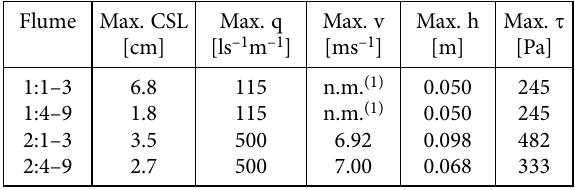
Table 7. Max. cumulative soil loss (CSL) and hydraulic forces, short-term tests series with focus on the upper (“1 – 3”) and lower (“4 – 9”) test sections, unvegetated, September 2014 Max. v Max. h Max. τ Flume Max. CSL Max. q [ms –1 ] [m] [Pa] [cm] [ls –1 m –1 ]